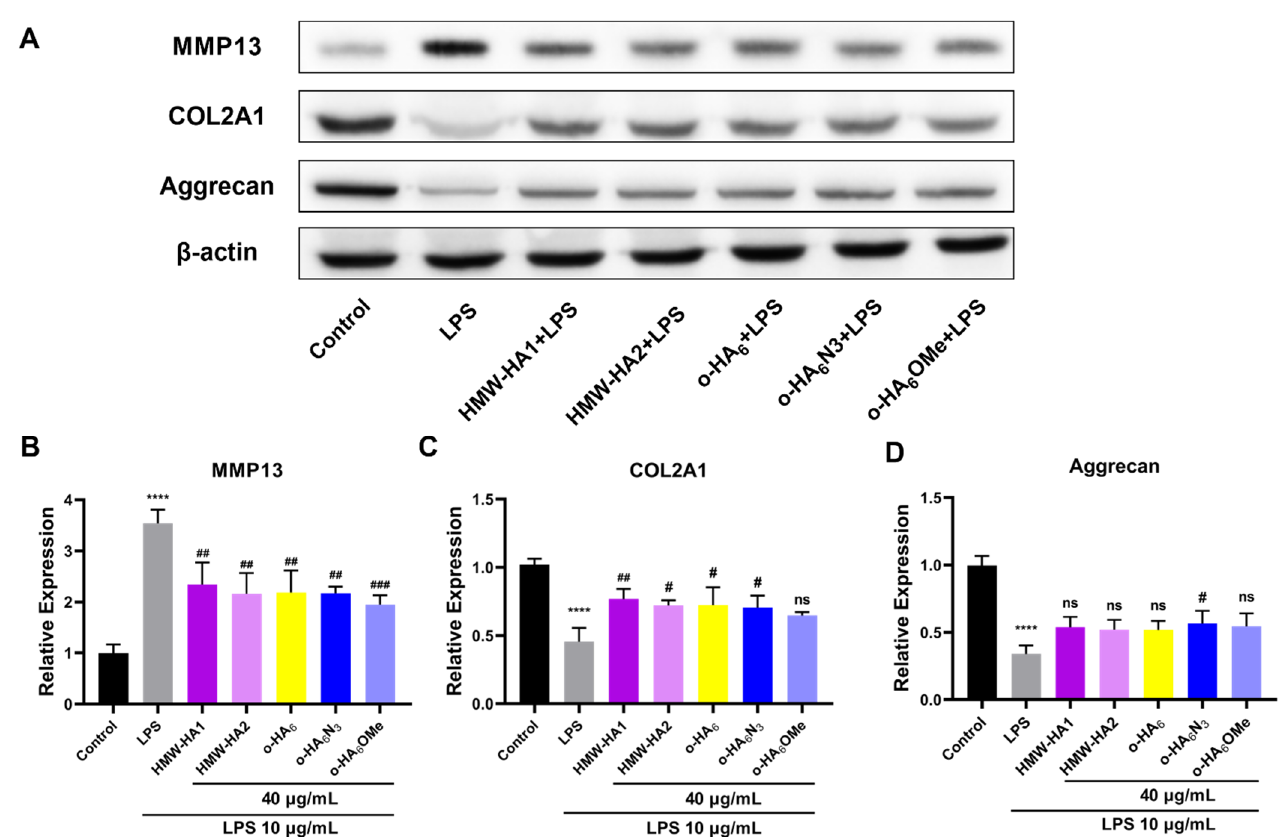
Figure 10. Effects of different HA derivatives on the degradation of ECM caused by ATDC5 inflam- matory injury. ATDC5 cells in the LPS group were stimulated with LPS (10 µ g/mL) for 24 h and then cultured in the medium containing 10% FBS for another 24 h. For different HA derivatives groups, ATDC5 cells were treated with LPS (10 µ g/mL) for 24 h and different HA derivatives (40 µ g/mL) for an additional 24 h, respectively. ( A – D ) The protein expression levels of ECM degradation related indicators (MMP13, Aggrecan and COL2A1) were detected by Western blot assay. **** p < 0.0001 vs. Control group; # p < 0.05, ## p < 0.01, ### p < 0.001, ns = not statistically significant vs. LPS group.